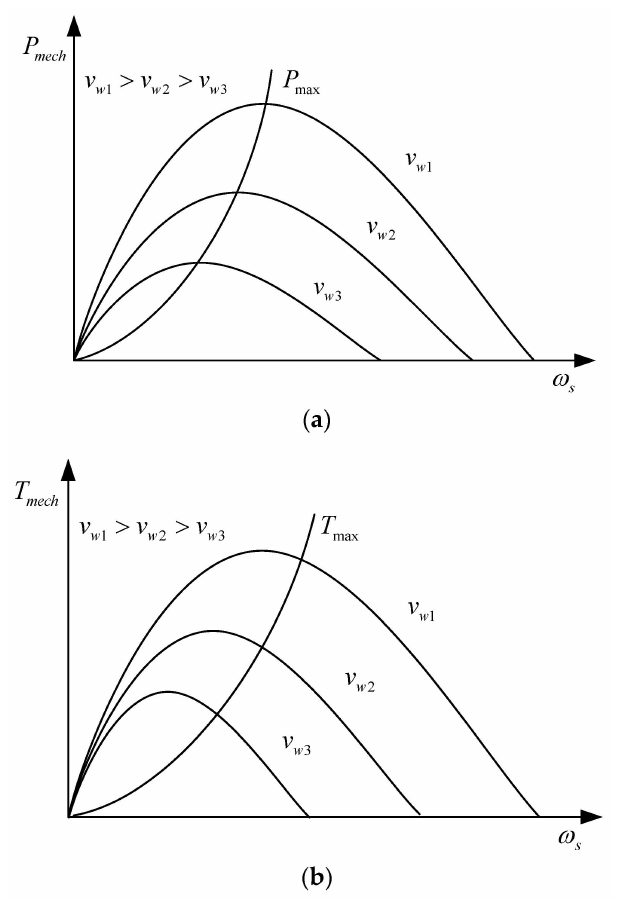
Figure 8. Wind turbine characteristics ( a ) Mechanical power versus rotor angular speed; ( b ) Mechanical torque versus rotor angular